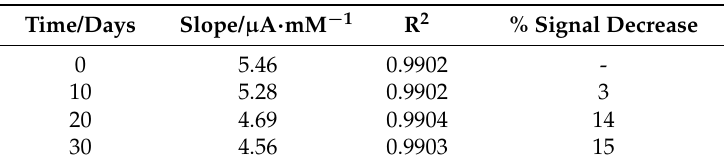
Table 5. Study of variability between amperometric measurements done with Chitosan–GOx/TiO 2 NTAs/Ti biosensor on different days from their